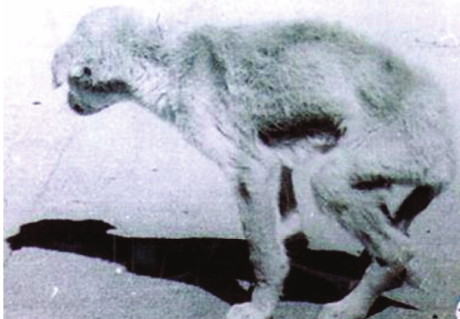
Figure 11: A highly emaciated infected dog with T. canis . Note the tucked up abdomen and posterior paralysis.